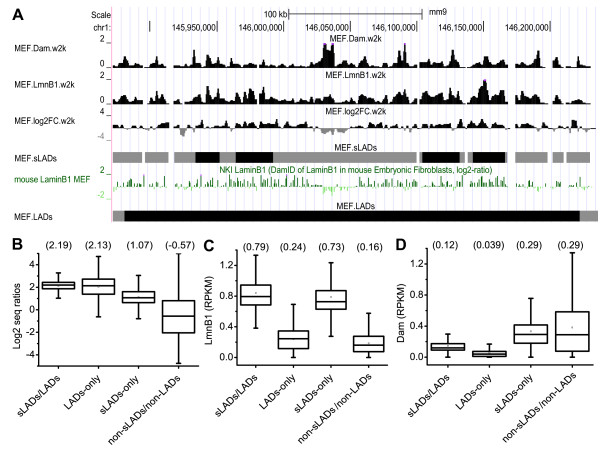
Comparisons of sLADs and LADs in MEFs. (A) A 400 kb segment in chromosome 1 shows that a LAD region is comprised of an array of sLADs and non-sLADs. Genome browser tracks follow the same scheme displayed in Figure 1A. (B-D) Bar plots of (B) log2 seq ratios, (C) LmnB1 read densities (RPKM) and (D) Dam read densities (RPKM) among genomic regions that belong to both LADs and sLADs (common sLADs/LADs), LADs but not sLADs (LAD-only regions), sLADs but not LADs (sLAD-only regions) and neither LADs nor sLADs (common non-sLADs/non-LADs). The upper and lower box boundaries indicate the 25th and 75th percentiles of the data, respectively. The upper and lower bars indicate the first and 99th percentiles, respectively. The median values are shown in parentheses.